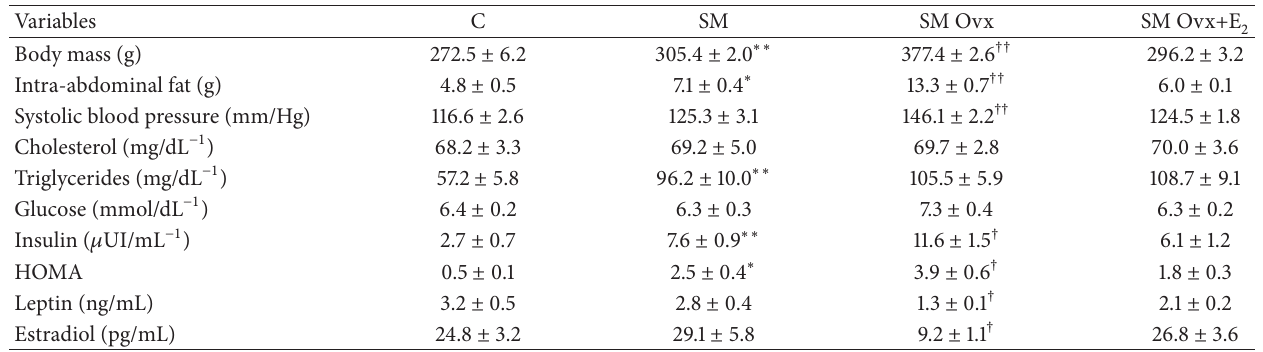
Table 1: General and biochemical